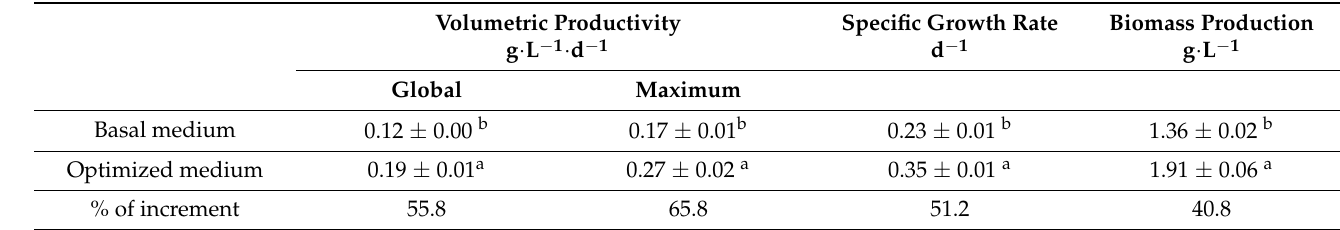
Table 7. Maximum and overall volumetric productivity (g · L − 1 · d − 1 ), specific growth rate (d − 1 ), and biomass production (g · L − 1 ) of the photoautotrophic cultures grown with the company’s basal medium and optimized medium in 1 L bubble columns. Different letters indicate significant differences between media. Values are given as mean ± standard deviation ( n = 3).